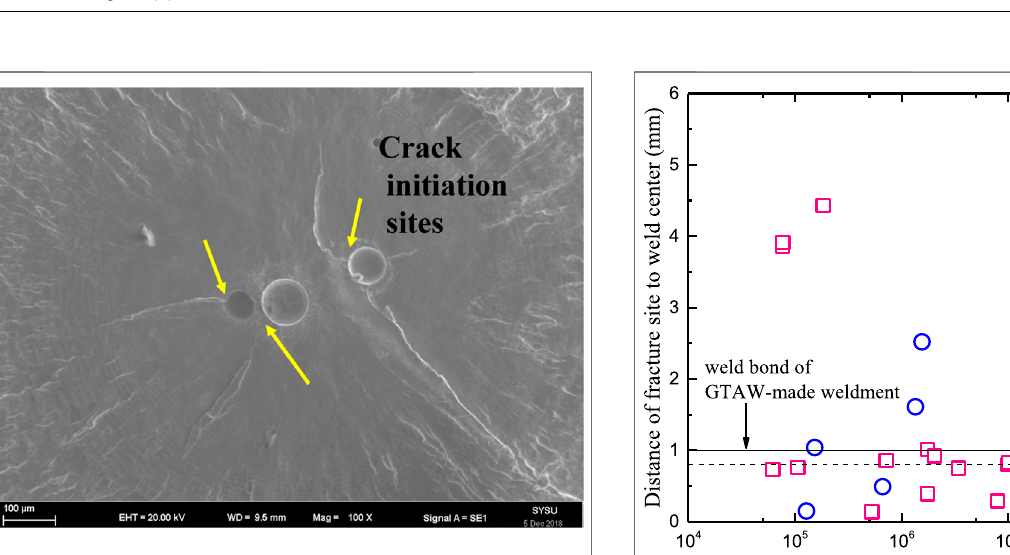
FIGURE 8 | Fracture surface of the specimen (LBW) tested at 250 MPa failed at 5.14 × 10 8 cycles. (A) overview of the fracture surface, (B) enlargement of the marked rectangle in (A) .